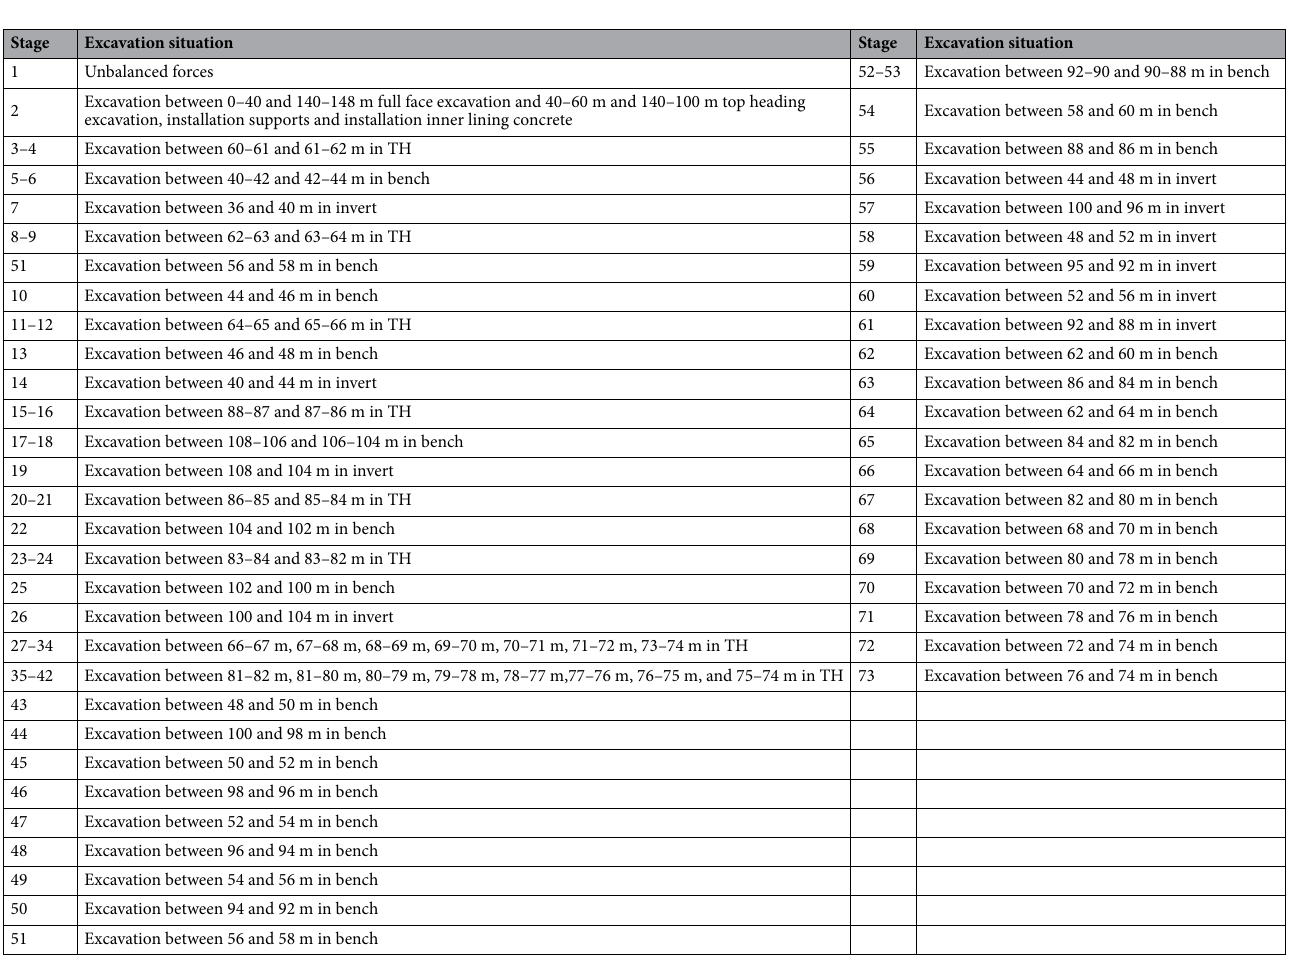
Table 12. Modelling stages.